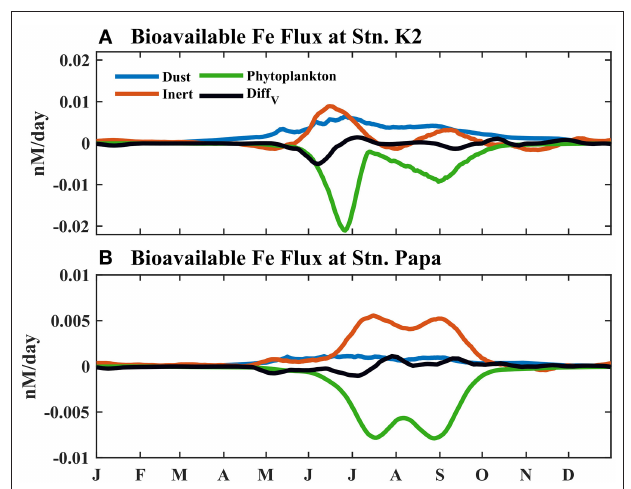
FIGURE 9 | Modeled seasonal cycle of each source/sink term for bioavailable Fe averaged within the mixed layer due to phytoplankton uptake, vertical diffusion, dust, and the conversion between inert Fe and BFe at (A) Stn. K2 and (B) Stn. Papa.